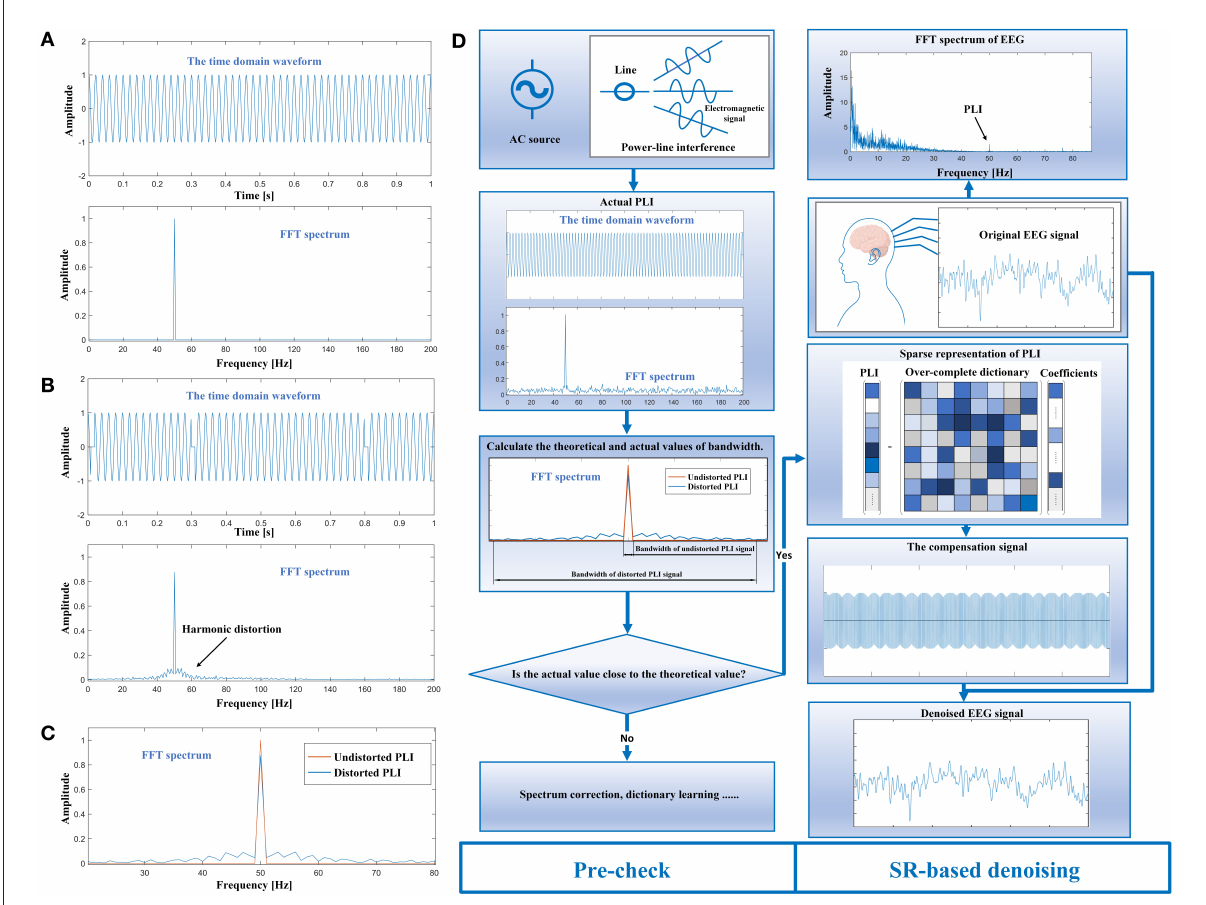
FIGURE1 (A) Time domain waveform and FFT spectrum of an undistorted PLI signal; (B) time domain waveform and FFT spectrum of a distorted PLI signal; (C) comparison of FFT spectrum of PLI signals in both cases; and (D) the procedure of the proposed method (by